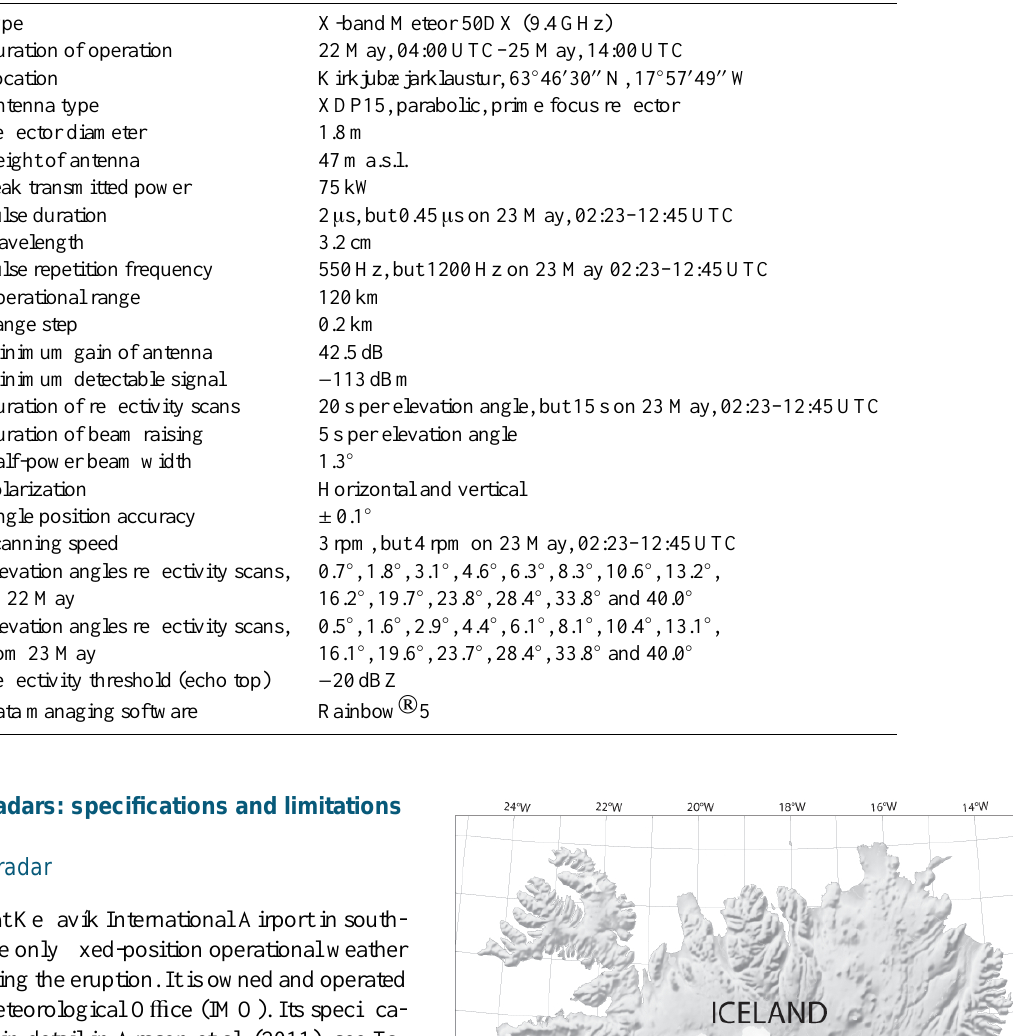
Table 1. Specifications of the mobile weather radar during the eruption of Grímsvötn in 2011.